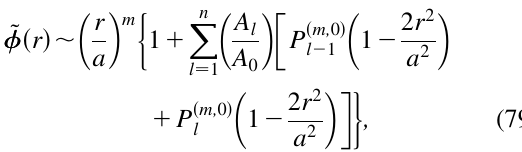
for the first o for k (cid:3) 0 , b=a (cid:3) 1 : 5 , o